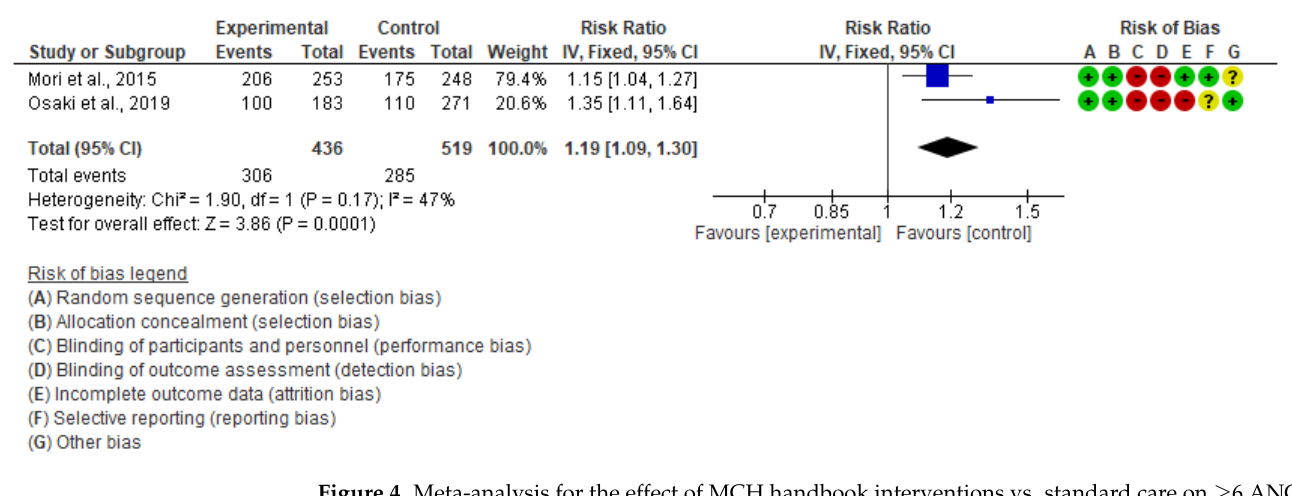
Figure 4. Meta-analysis for the effect of MCH handbook interventions vs. standard care on ≥ 6 ANC visits [19,20]. Red color with a − symbol means a high risk of bias, yellow color with a ? symbol means an unclear risk of bias, and green color with a + symbol means a low risk of bias.